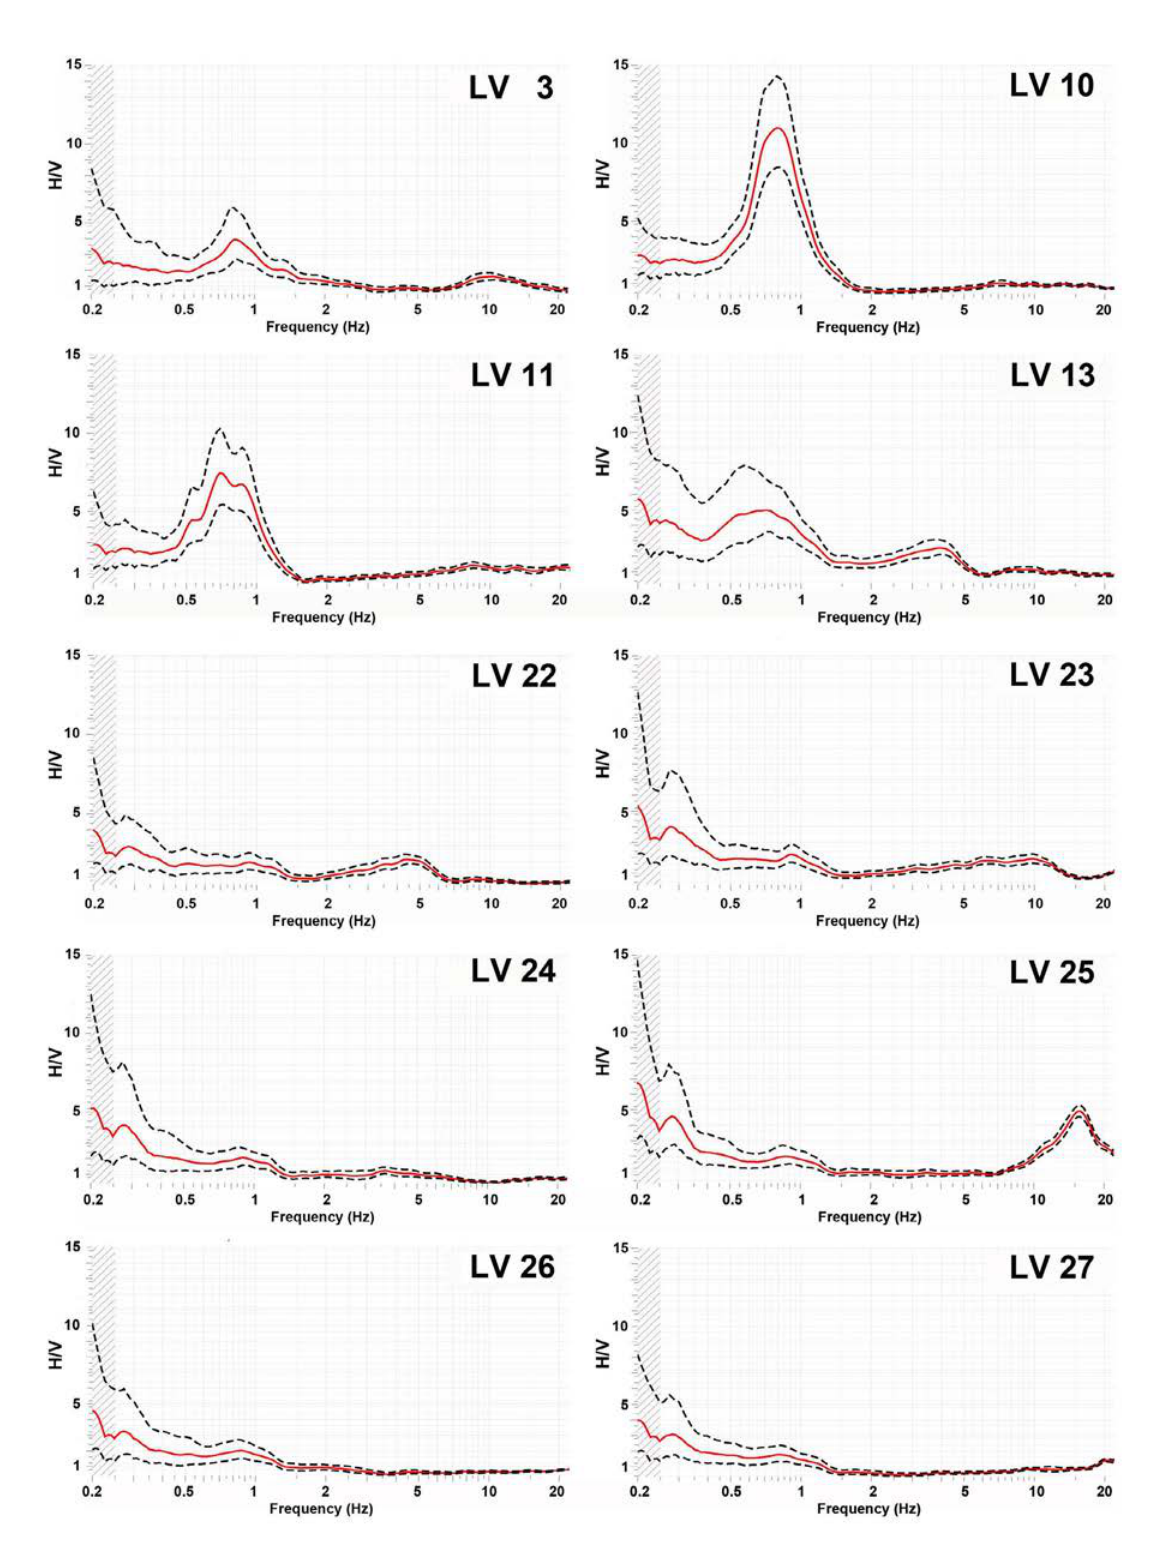
Figure 8. Results of H/V measurements at 10 sites along the ancient Via Laurentina . Red line: average H/V spectral ratio; dashed black lines: standard deviation of the H/V spectral ratio; dotted zone: unreliable frequency range of the H/V spectral